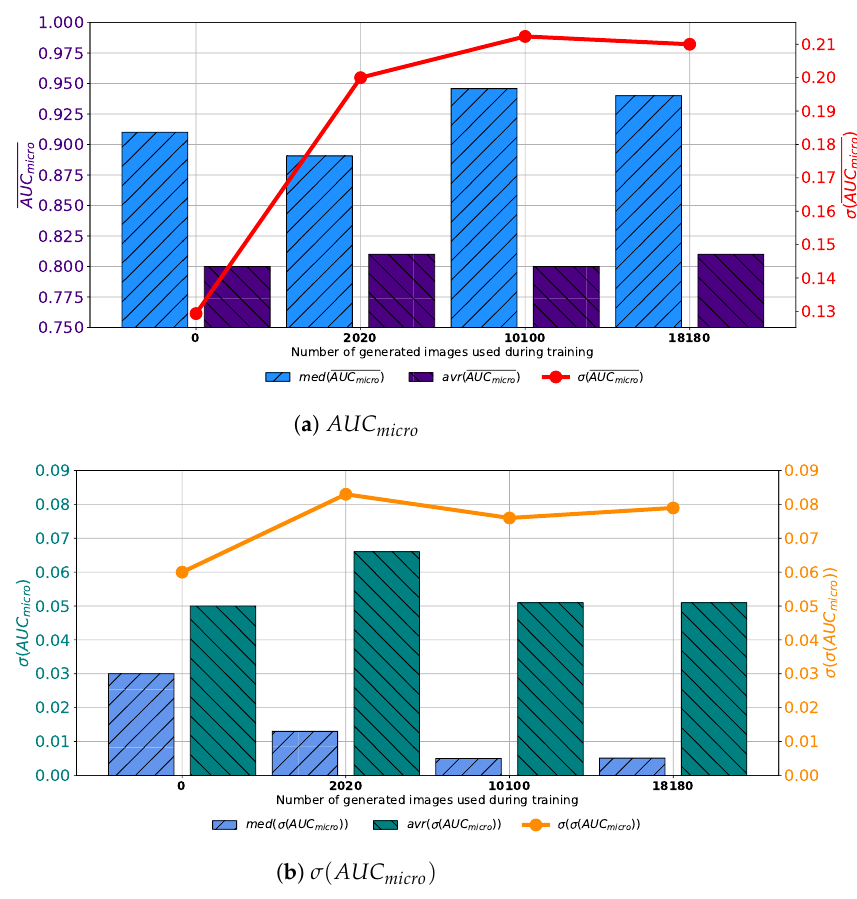
Figure 14. Median, average AUC micro and standard deviation of AUC micro and σ ( AUC micro ) for the case of VGG-16 trained with images generated by GAN in 1000